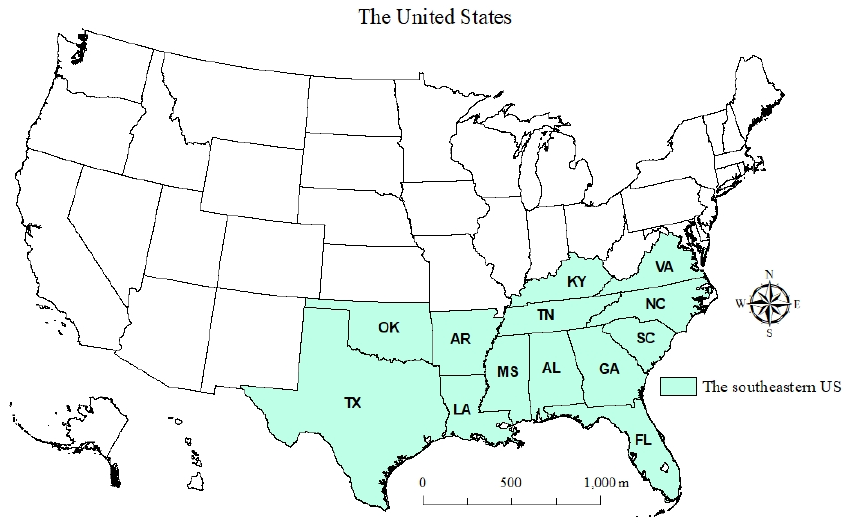
Figure 1. Location of the study area in the map of the United States.